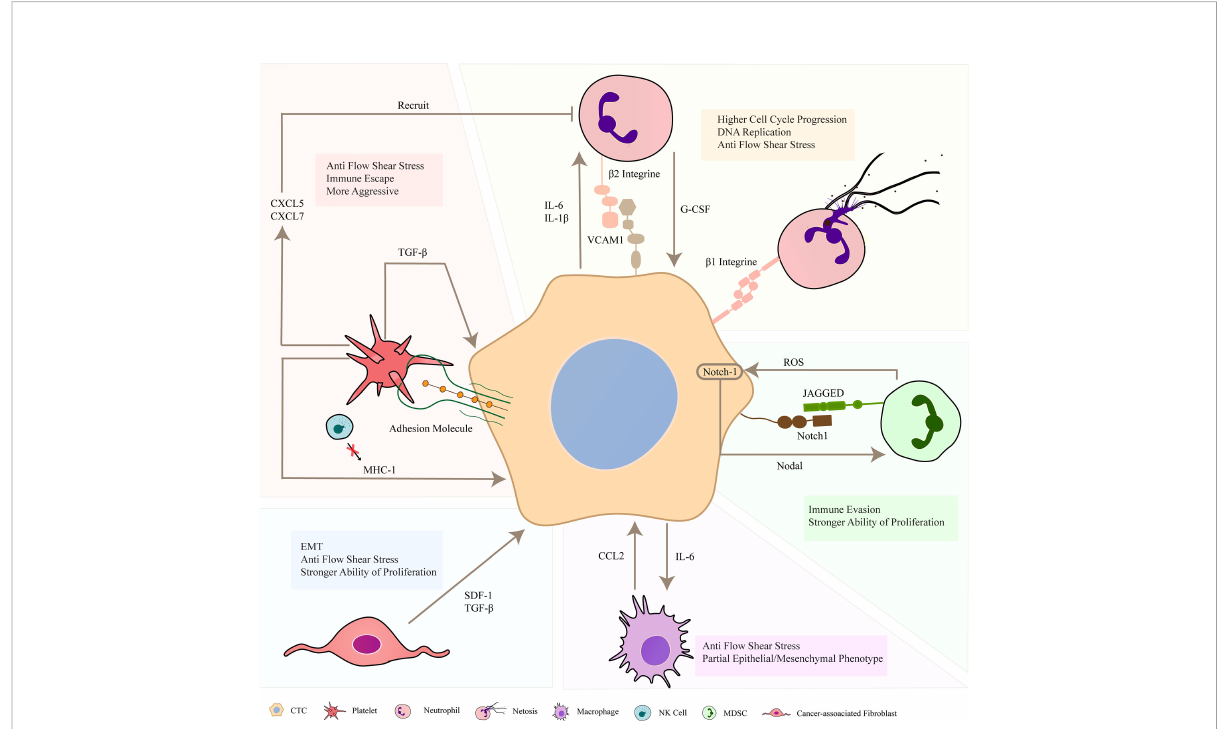
FIGURE 3 Formation of heterotypic circulating tumor cell (CTC) clusters. In the blood circulation, CTCs forms cell clusters with other non – tumor cells, such as neutrophils, platelets, macrophages, MDSCs and CAFs. These non – tumor cells can combine with cancer cells through key adhesion molecules to prevent apoptosis, and maintain the survival of CTCs in vivo through multiple ways. They can release some cytokines to strengthen the invasion and proliferation of cancer cells, and be more resistant to fl uid shear stress (FSS). In addition, cancer cells also release related substances to act on non – tumor cells and recruit them to adhere to CTCs. In short, they jointly promote the occurrence and development of cancer in the blood